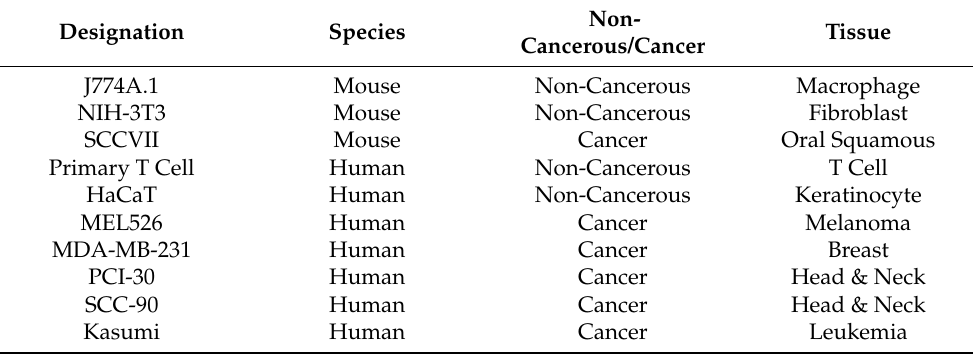
Table 1. Exosome Sources and Producer Cell Lines Characteristics